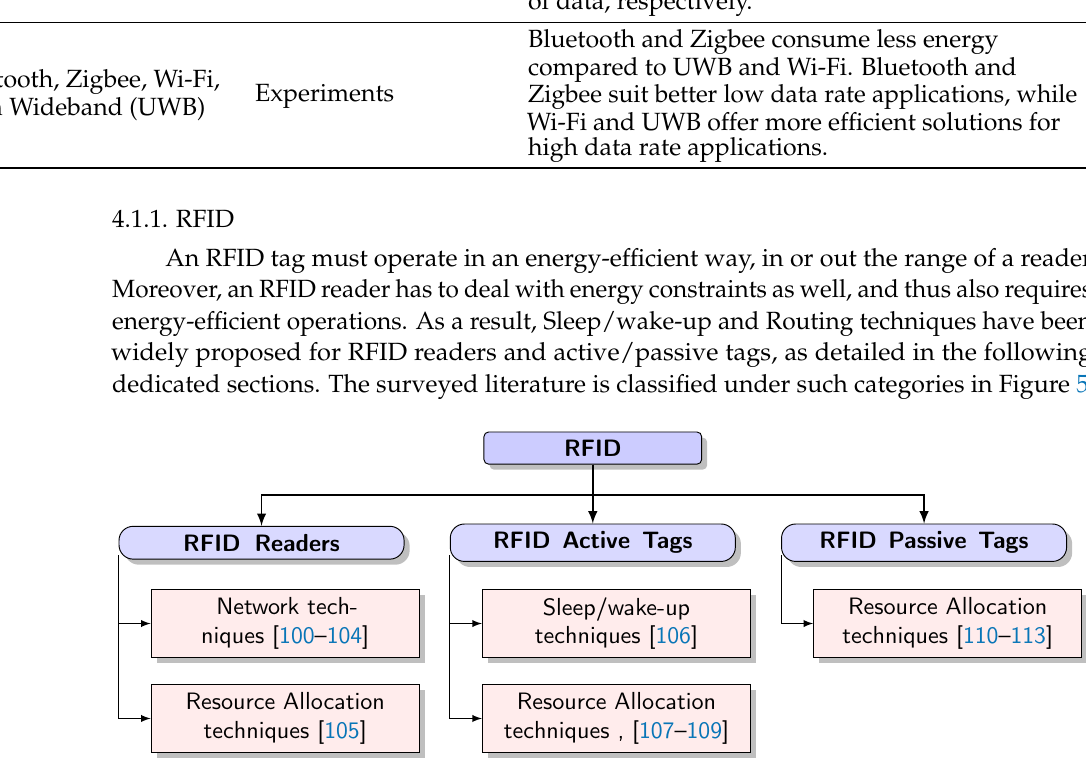
Figure 5. Energy efficiency techniques for RFID